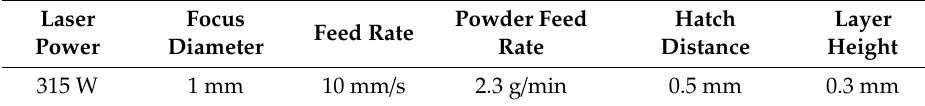
Table 1. Parameters of the laser metal deposition (LMD) process. Laser Power